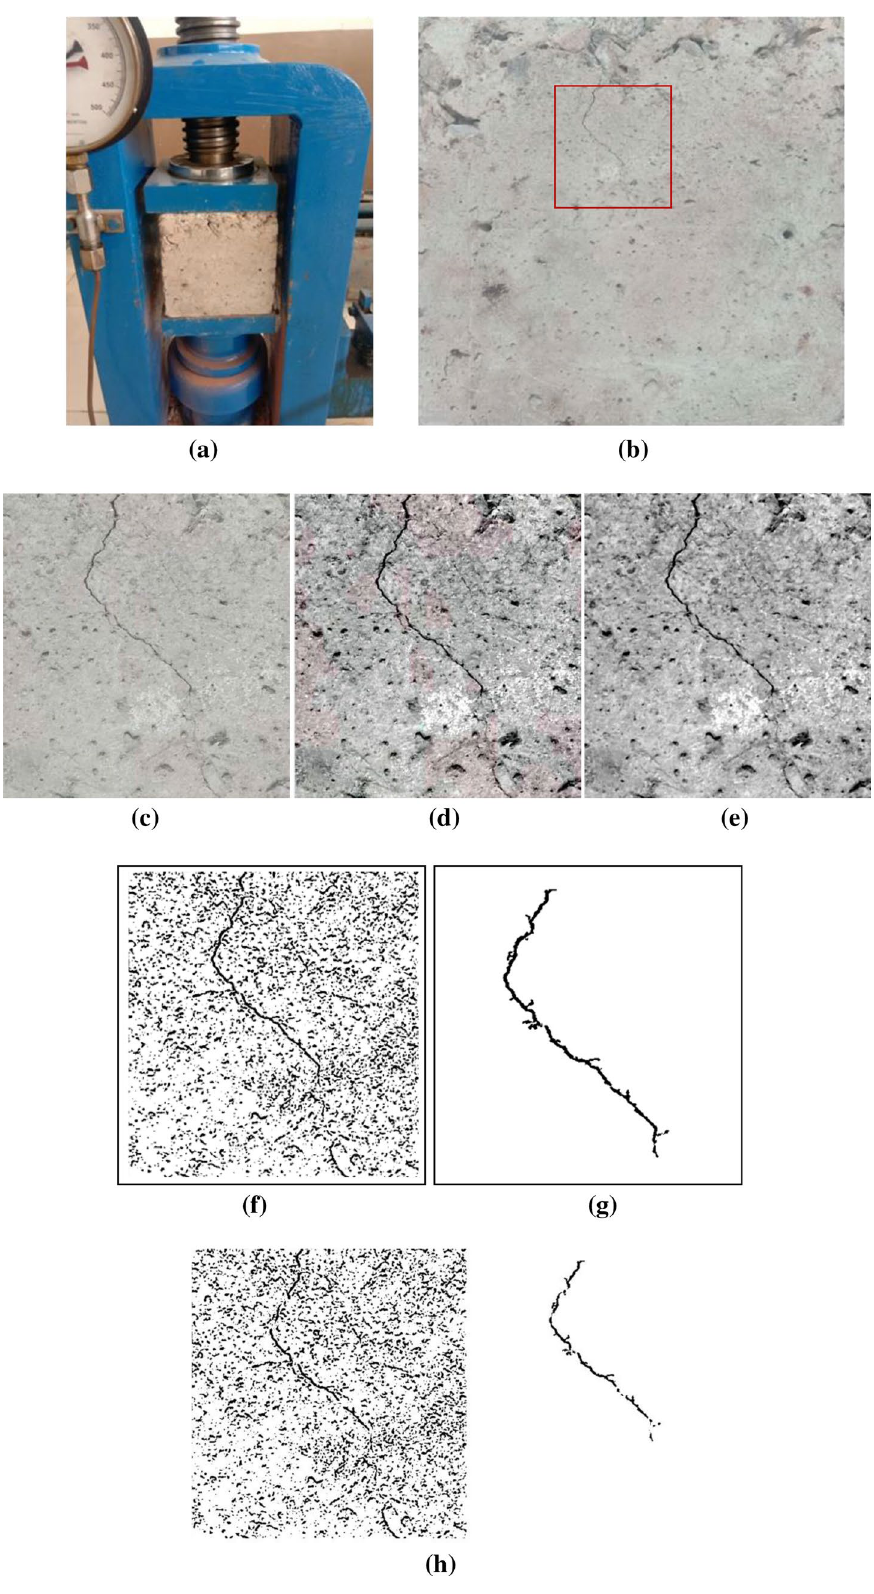
Figure 8. ( a ) Compression testing setup with CBC having minor crack ( b ) Small crack developed and localised ( c ) Crack segment ( d ) Contrast stretched image ( e ) Gray scaled image ( f ) Noisy spectral clustered image ( g ) Noise-free ( h ) Crack detection with spectral clustering method without